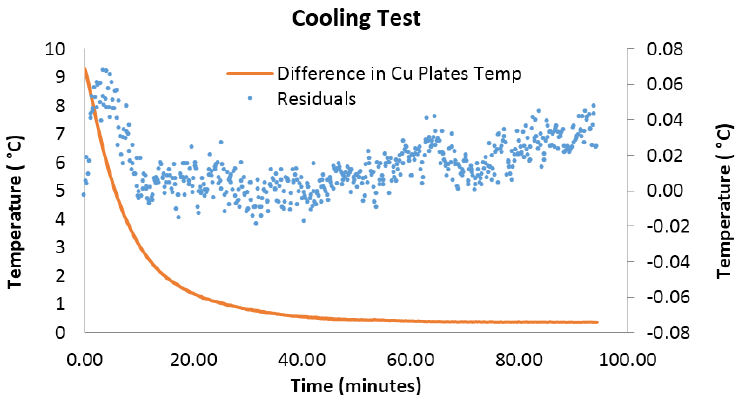
Figure 8. Profile of temperature difference of Cu plates and temperature residuals of fitted curve (cooling Test, with respect to time).